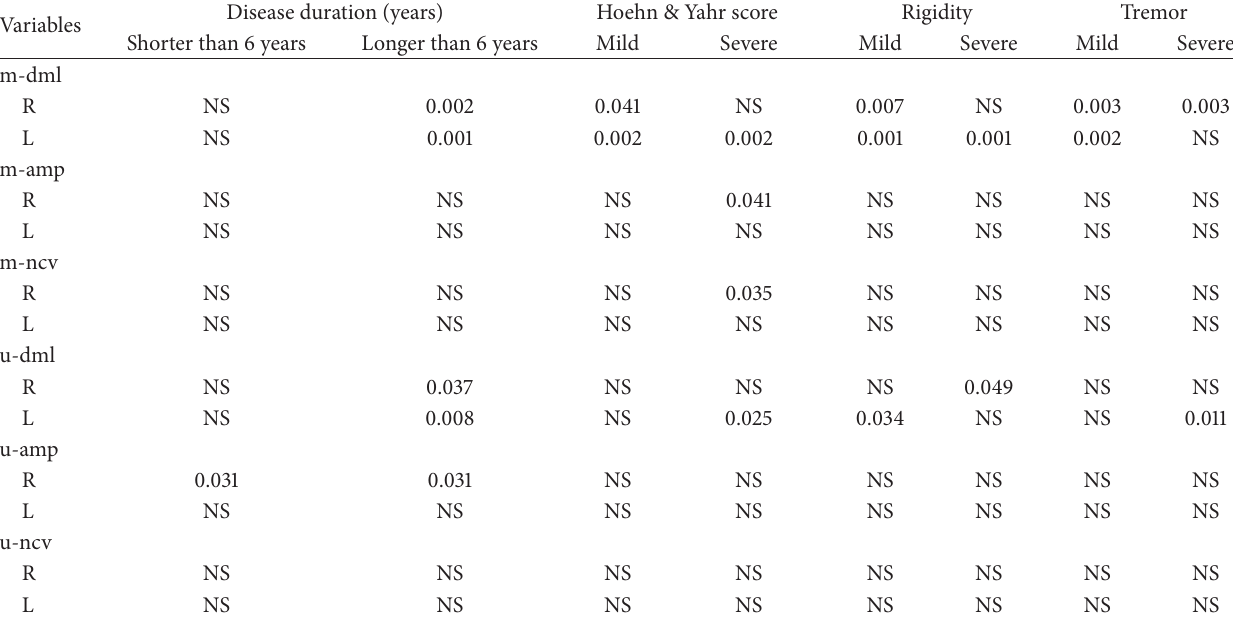
Table 5: The statistical comparison of mean indices of median and ulnar nerve electrophysiologic parameters at the wrist level between mild and severe patient groups and